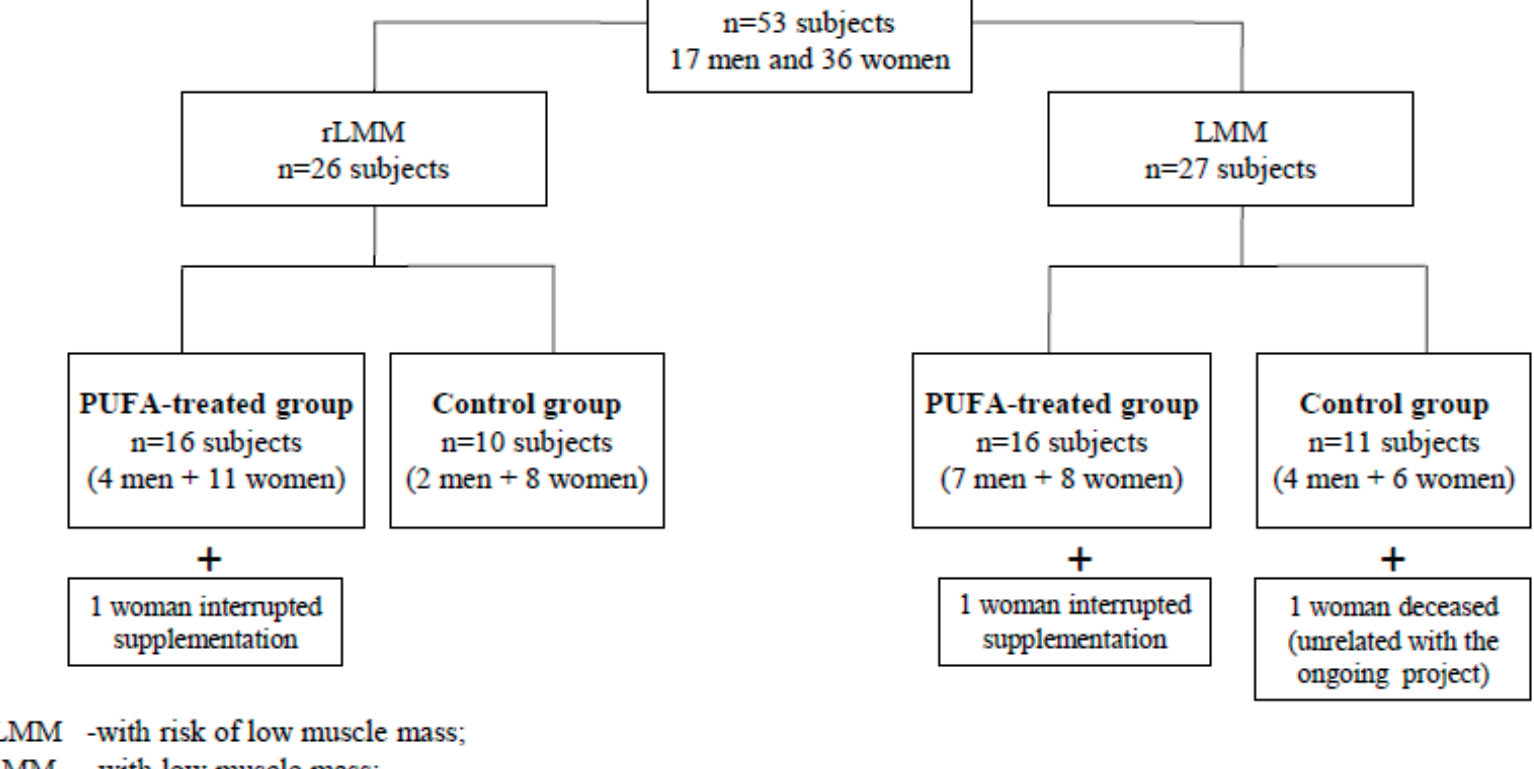
Figure 1. The algorithm of allocation of study subjects to analyzed